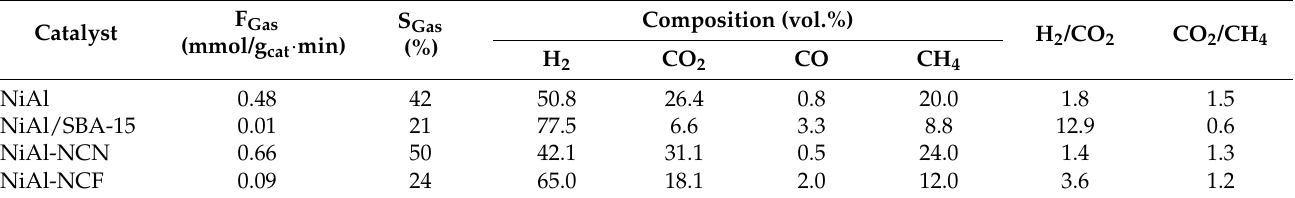
Table 3. Gas-phase product